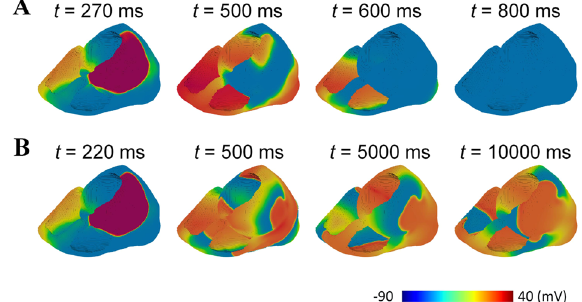
Fig. 6 Simulation results of reentry arrhythmias in the realistic 3D bi-ventricle model. The S2 stimulus was applied to the upper part of the LV epicardium to initiate scroll waves. A The scroll wave in the wild-type condition. The lifetime was only 410 ms, and the recorded onset and disappearance time of the scroll wave were separately 270 and 680 ms. B The scroll wave in the T618I mutation condition, which persisted throughout the whole simulation period of 10,000 ms. mutation conditions, a premature stimulus applied on the upper part of the left ventricle during the vulnerable window could successfully